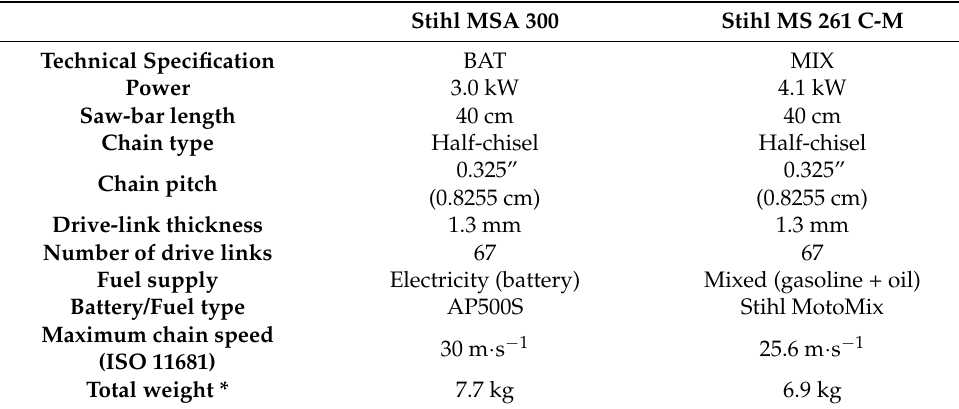
Table 1. Technical specifications of the two